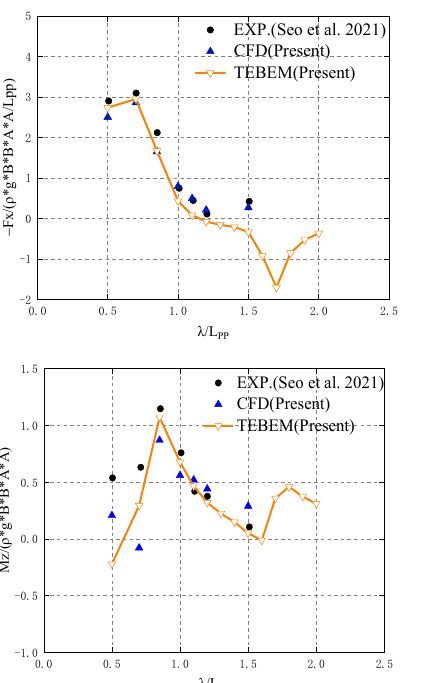
Figure 14. RAO of 6-DOF motion of KVLCC2 under H = 0.02 L PP , χ = 120°, β = 0°, and U = 6.0 kn.